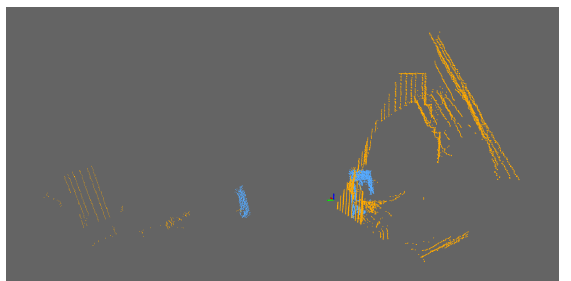
Figure 12: Cleaned scan of office room with a mirror from the side. Valid points are green, points on the mirror plane are turquoise, and points behind the mirror plane are orange.